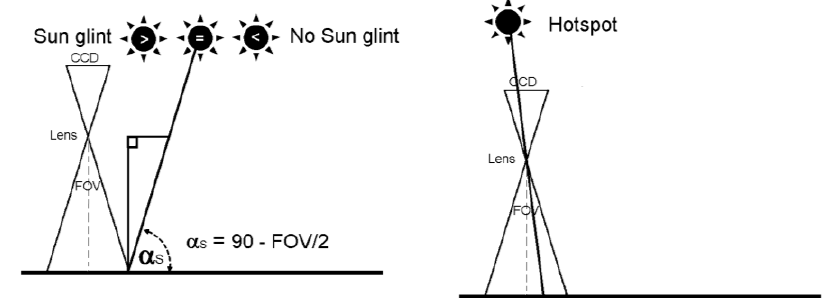
Figure 2. ( Left ) Sun glint effect : the sun glint effect is produced from specular surfaces such as water, glass or metal when the angle of incidence of the sun equals the angle of reflection and this angle is lower than the field of view (FOV) of the camera. In particular, if the sun elevation ( α S ) is greater than 90 minus 1/2 the FOV of the camera, rays from the sun can be reflected directly onto the charge-coupled device (CCD) causing a sun glint defect on the photo; ( Right ) Hotspot effect : the hotspot is produced due to a direct alignment between the sun, the camera and the position on the ground, that is, the point on the ground opposite the sun in relation to the camera. The hotspot produces a change of brightness in this point of the image and its surroundings.